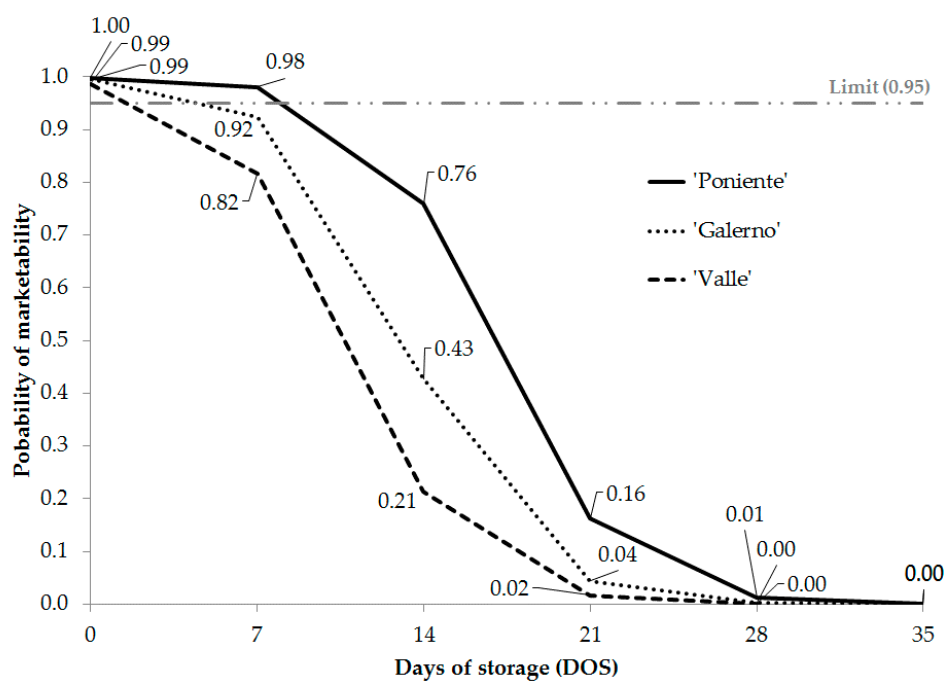
Figure 6. Timeline of the probability of marketability as a function of the days of storage (DOS) for the Poniente, Galerno, and Valle cucumber cultivars.